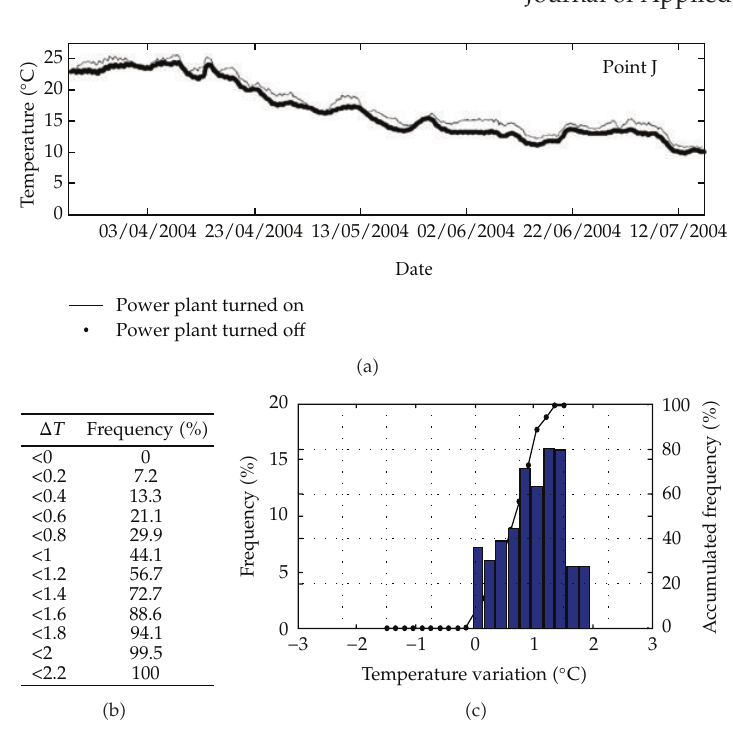
Figure 18: Time evolution of the water temperature calculated with the model in the zone inside the port (cid:3) point J (cid:4) with the power plant turned on and turned o ff . Histogram of the Δ T in point